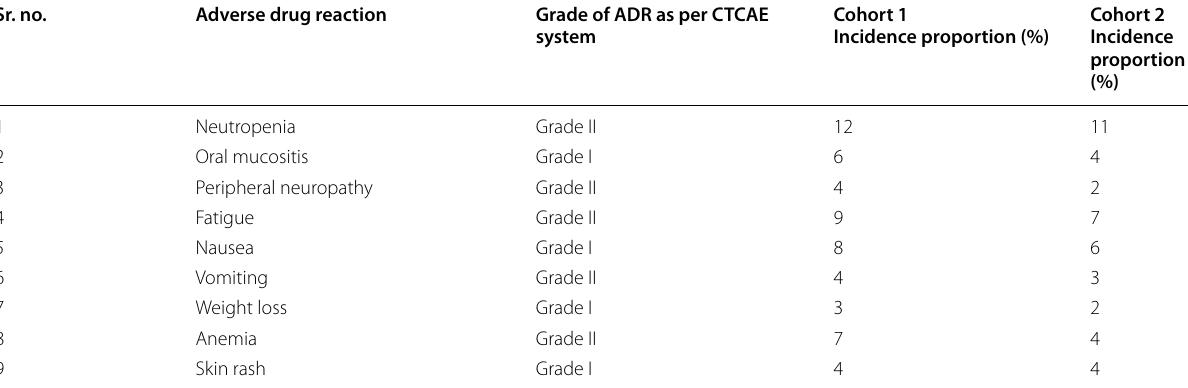
ADR adverse drug reaction, CTCAE version 5 common terminology criteria for adverse events. Data presented as percentage. Data analyzed by Fisher’s exact test followed by Tukey’s multiple comparison test ( CI 95%, P < 0.05) =